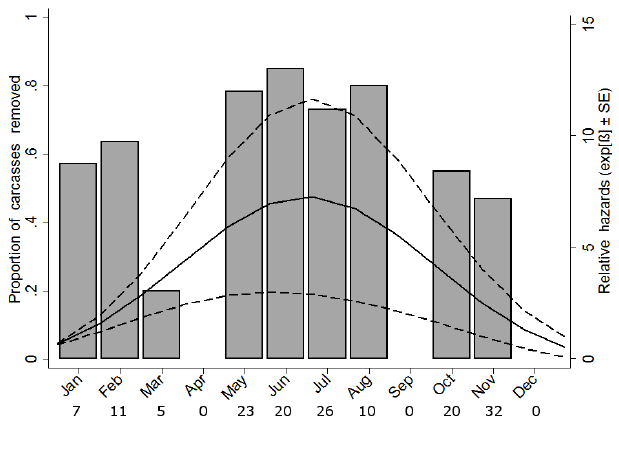
Fig. 1 . Effect of date on scavenger removal of bird carcasses placed below urban windows. The grey bars indicate the proportion of carcasses removed in a given month (indicated on the left y-axis), while the solid and dashed black lines indicate the relative hazards and the standard error generated by the Cox proportional hazards model, respectively (indicated on the right y-axis). Relative hazards are a relative rate of carcass removal over a given interval, and in July, it was ~6x greater than in January. The number of carcasses placed in a given month is indicated below the month on the x-axis. The data were collected near 44 Edmonton area homes, Alberta,